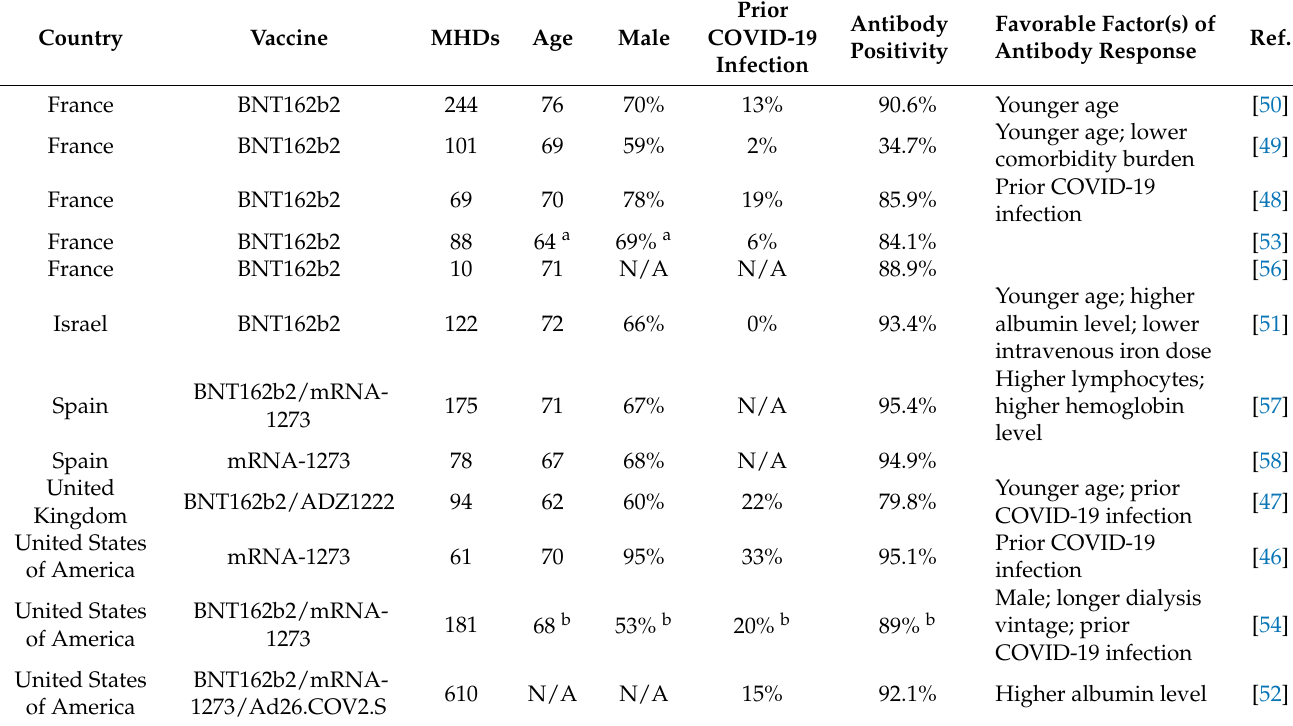
Table 3. Characteristics following COVID-19 vaccination in patients with